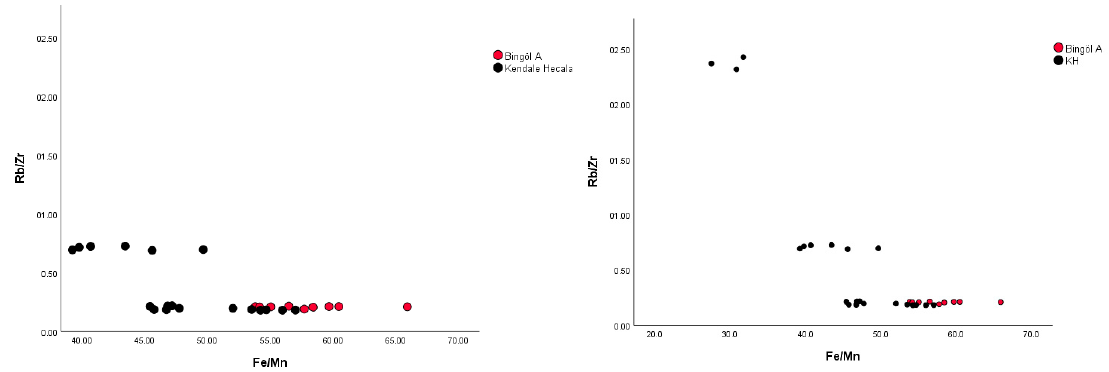
Figure 11. Bivariate plot of Fe/Mn vs. Rb/Zr showing obsidian artefacts and Bingöl A geological samples.